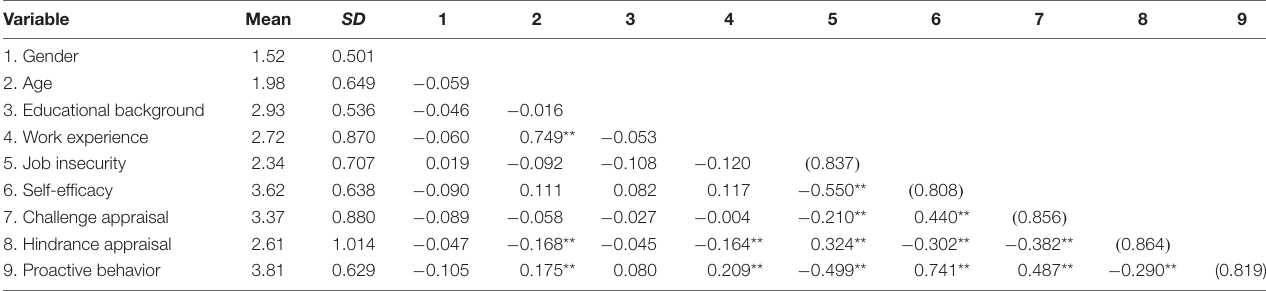
TABLE 3 | Mean, standard deviation, and correlation coefficient of variables. Variable